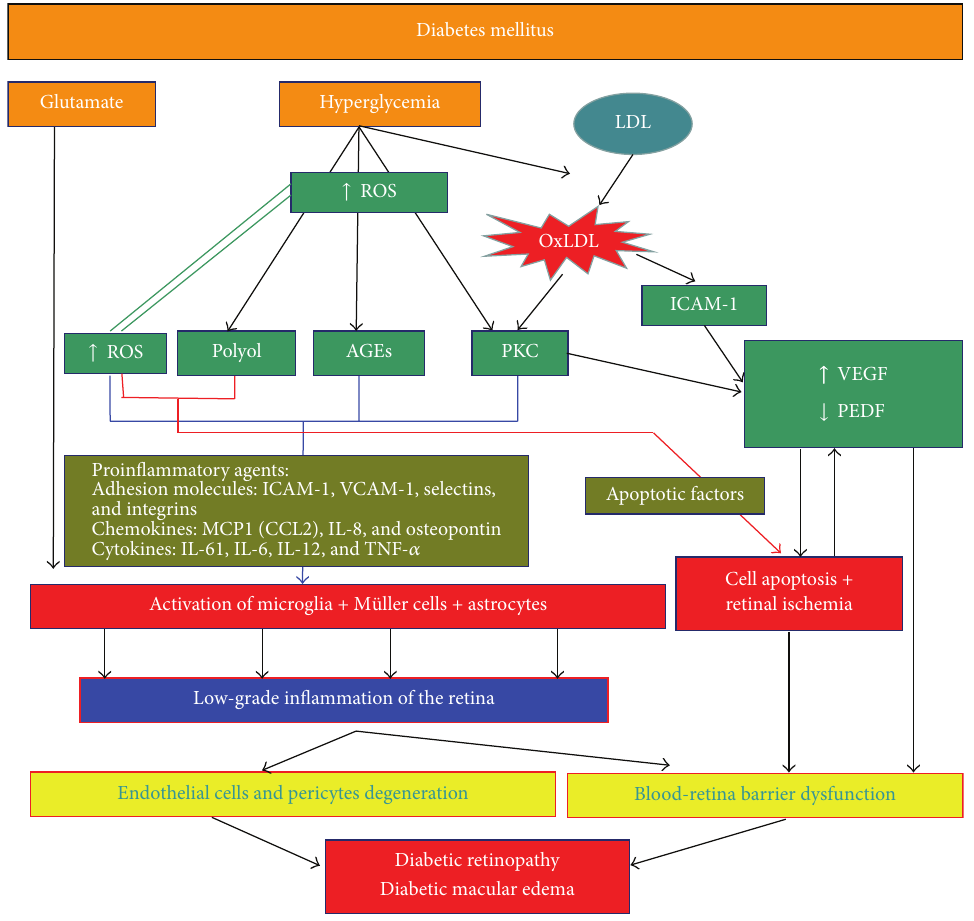
Figure 2: The different pathways in the development of diabetic macular